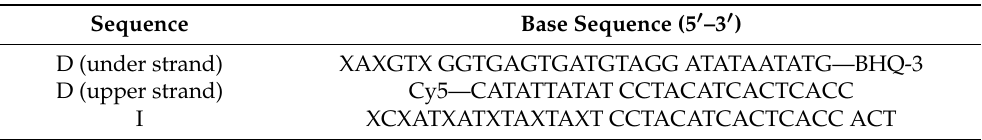
Table 2. DNA used in the experiments. X refers to the modification point of azobenzene.